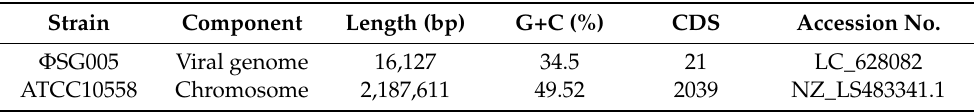
Table 1. General genomic information of Φ SG005 and S. gordonii ATCC10558. The reference